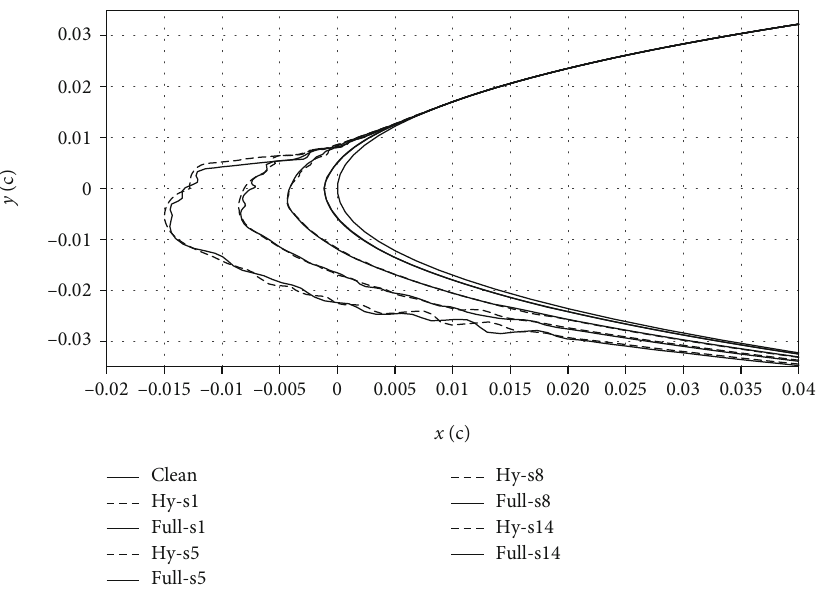
Figure 14: Comparison of ice accretion between hybrid and full-scale